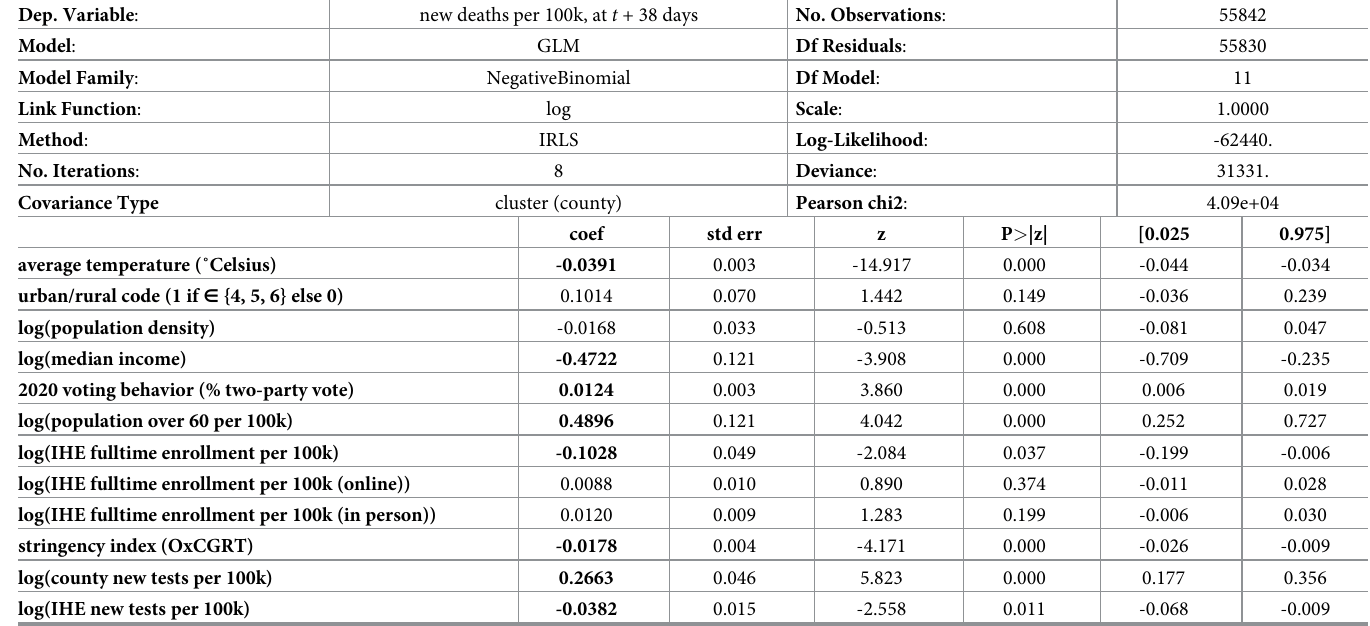
Table 1. Generalized Linear Model (GLM) Regression: Predicting COVID-19 deaths, at t + 38 days. Regression table under a Negative Binomial model. See Table C and Fig D in S1 Text for descriptions of variables. Standard errors were adjusted for clustering at the county level. Coefficients in bold are statistically significant at the 95% confidence